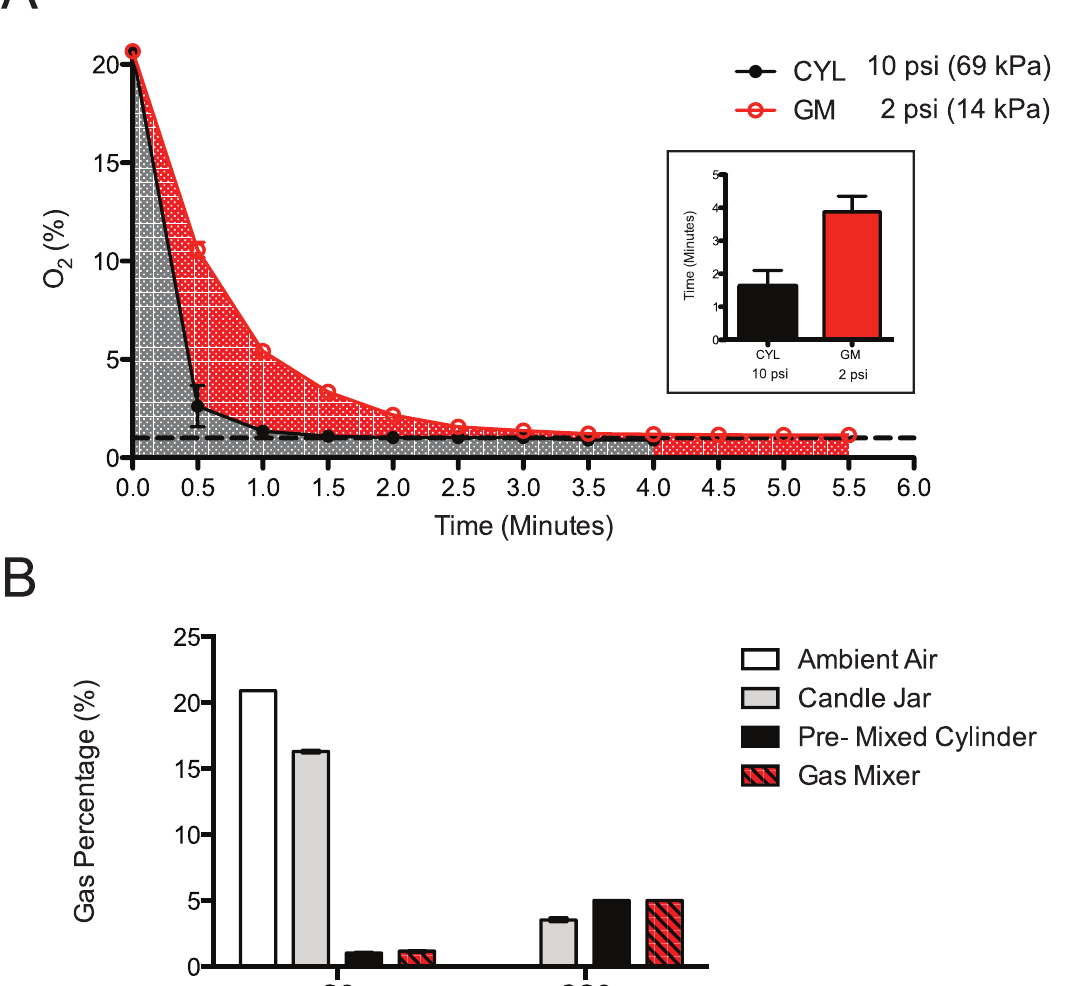
Figure 2. Gas concentration comparisons for field applicable culture methods. A. Graph of time and oxygen percentage as measured through modular incubator chamber output nozzle. Inset shows the time to reach 1% O 2 for each method. Four independent experiments were performed and error bars represent standard deviation. B. Concentrations of CO 2 and O 2 for field applicable culture methods: Candle Jar, Pre-mixed gas cylinder (CYL), and gas-mixing (GM) device, compared to ambient atmospheric percentages. Three independent measurements were made (with five measurements for the gas-mixing device) and error bars represent standard deviation.